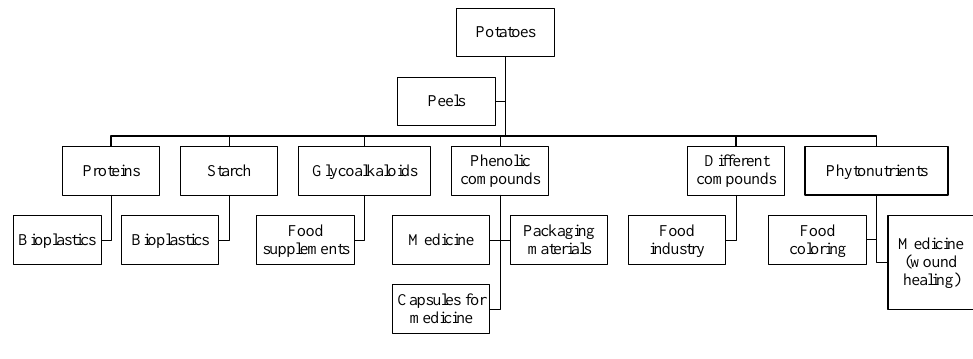
Fig. 2. Potatoes and their uses in